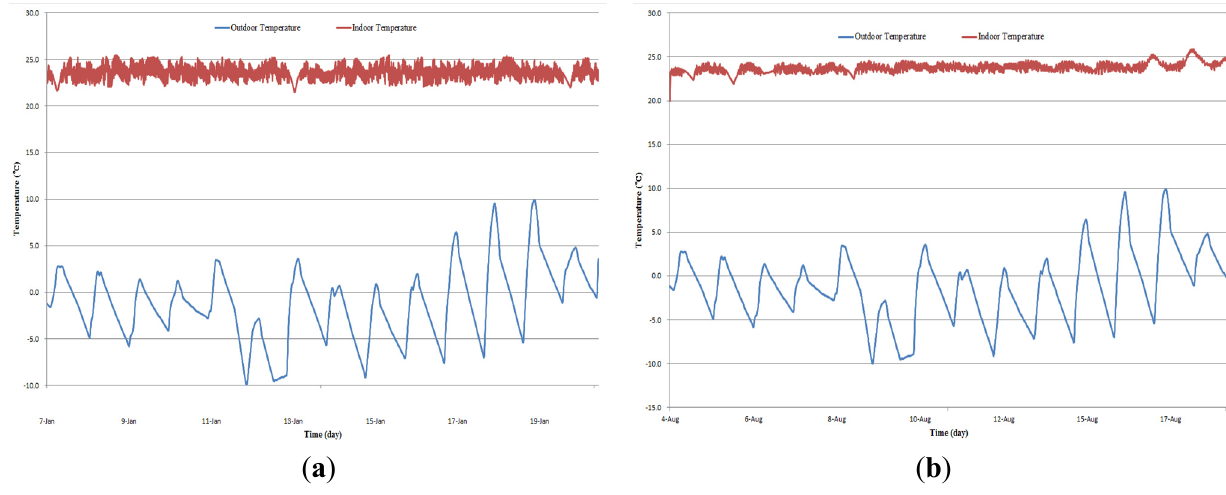
Figure 14. Indoor environment conditions of the Multi-GHP system in the winter: ( a ) existing operation condition of Multi-GHP system (Case 1-1); ( b ) sequencing operation condition of Multi-GHP system (Case